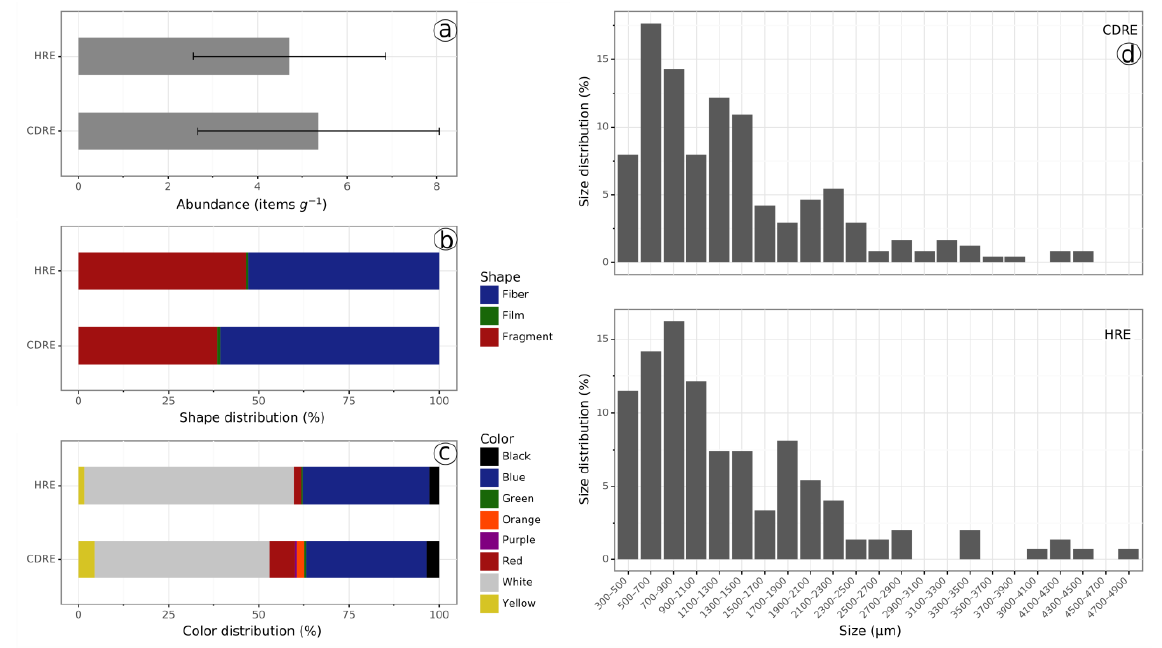
Figure 2. Microplastic characteristics in the hard clam Meretrix lyrata from Han River Estuary (HRE) and Cu De River Estuary (CDRE): ( a ) abundance; ( b ) shape distribution; ( c ) color distribution; and ( d ) size distribution.